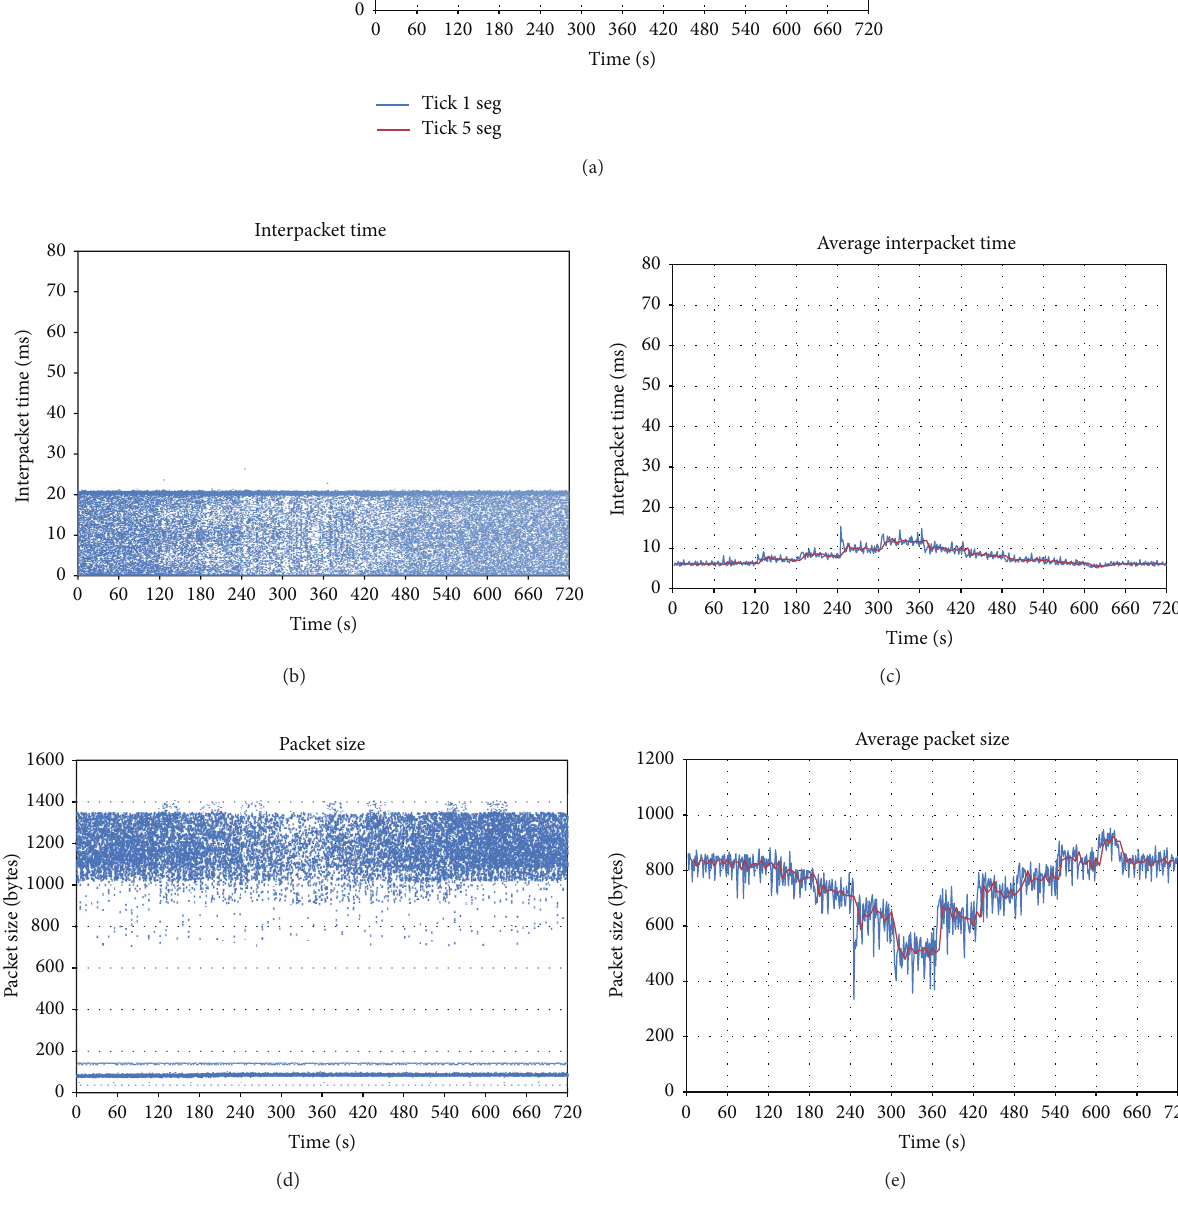
Figure 3: Effect of downlink bandwidth limitations on Skype : (a) evolution of sent throughput; (b) interpacket time; (c) average interpacket time; (d) packet size; (e) average packet size